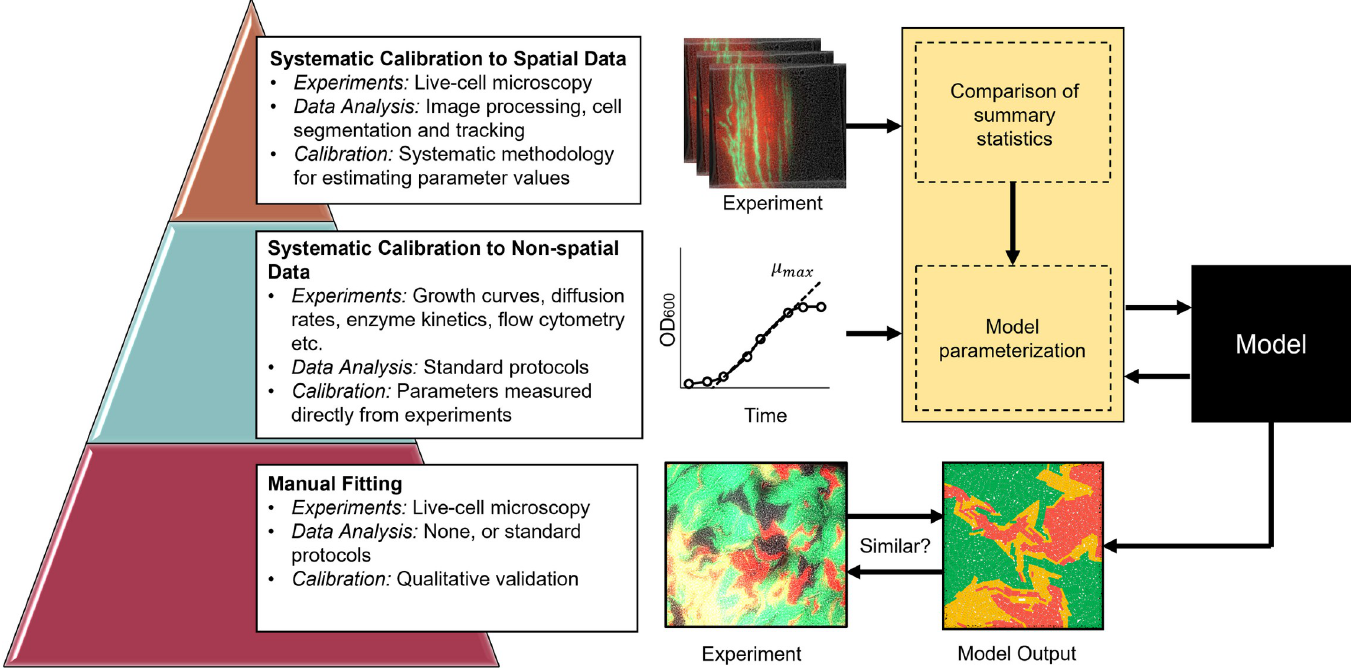
Fig 3. Model calibration techniques for spatiotemporal models of microbial communities. Manual fitting involves direct adjustment of parameter values to achieve qualitative agreement between model predictions and observations. Nonspatial calibration is often systematic (based on a goodness of fit function) but is based on experiments that do not incorporate the spatial features of the system. Spatial calibration , against spatially distributed data, can be systematic (SSE-based) but must rely on summary statistics collected from the data.